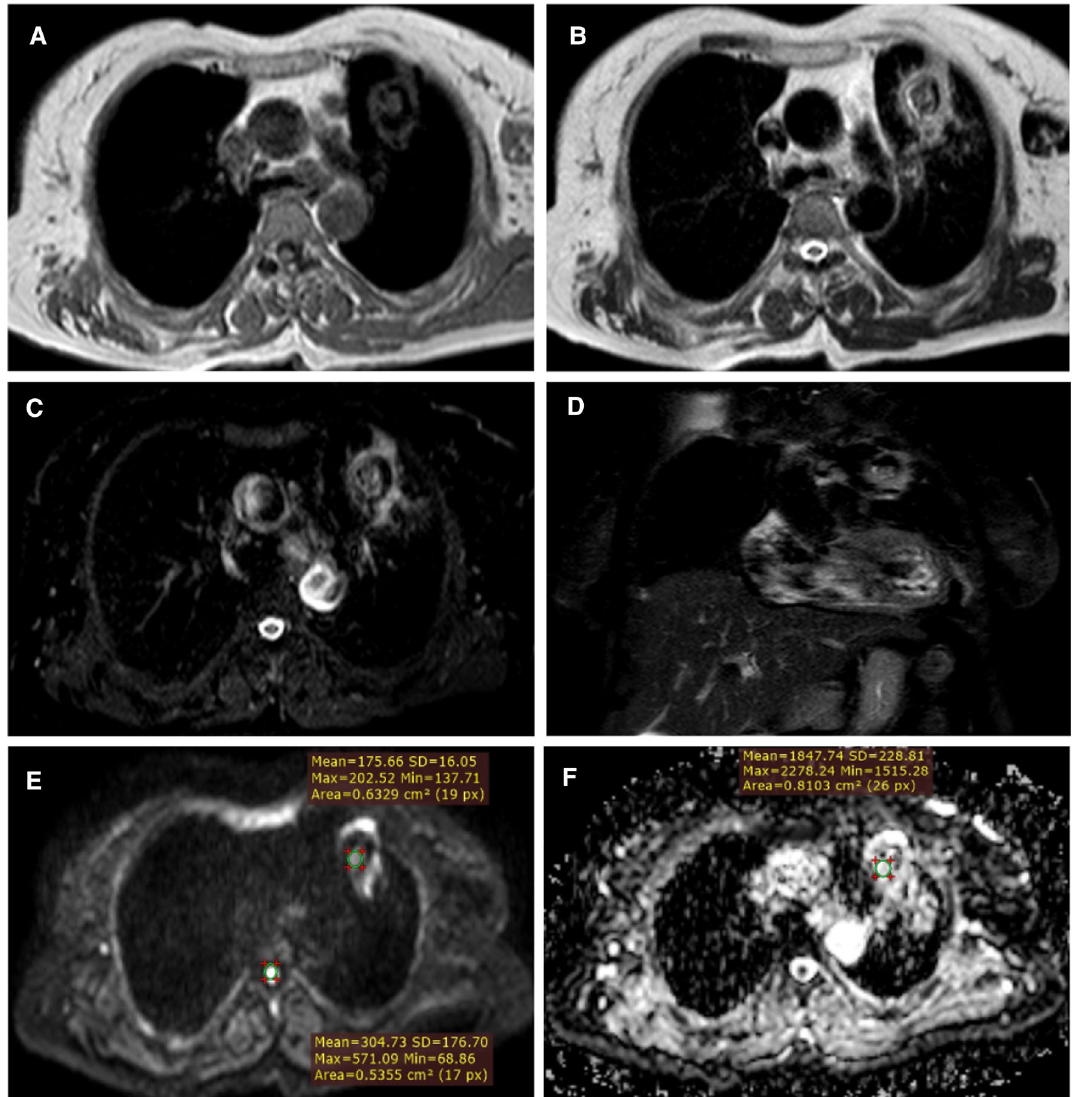
Fig. 4 Female patient 72‑years‑old presenting with dyspnea and cough. A‑D: Axial T1 ( A ), axial T2 ( B ), axial STIR ( C ), coronal STIR ( D ), weighted MR images show left upper lobar cavitary lesion with soft tissue within and surrounding consolidation. They elicit isointense T1 signal and hyperintense T2 signal relative to the surrounding muscles with air crescent sign. DWI ( E ) and ADC map ( F ) images show facilitated diffusion and LSR ADC mean value 1.85 with ADC min value 1.51. Bronchoscopic examination with brocho‑alveolar lavage and cytology revealed fungal infection